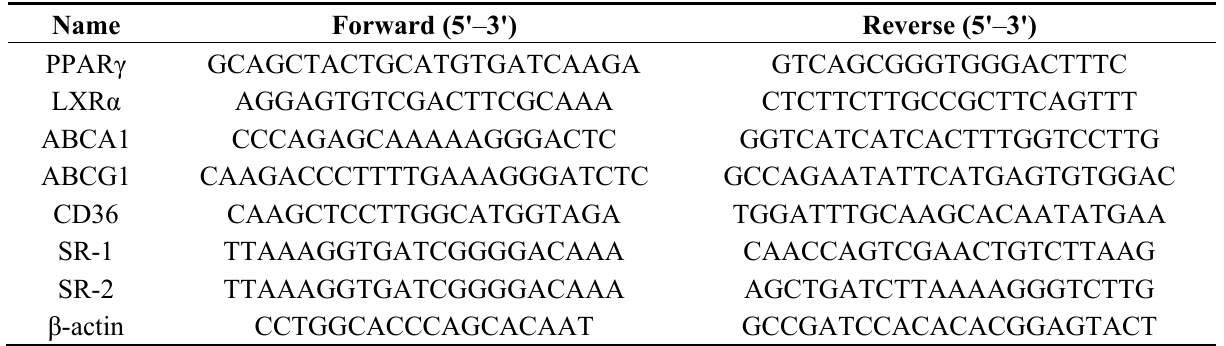
Table 1. Primers used in realtime quantitative PCR